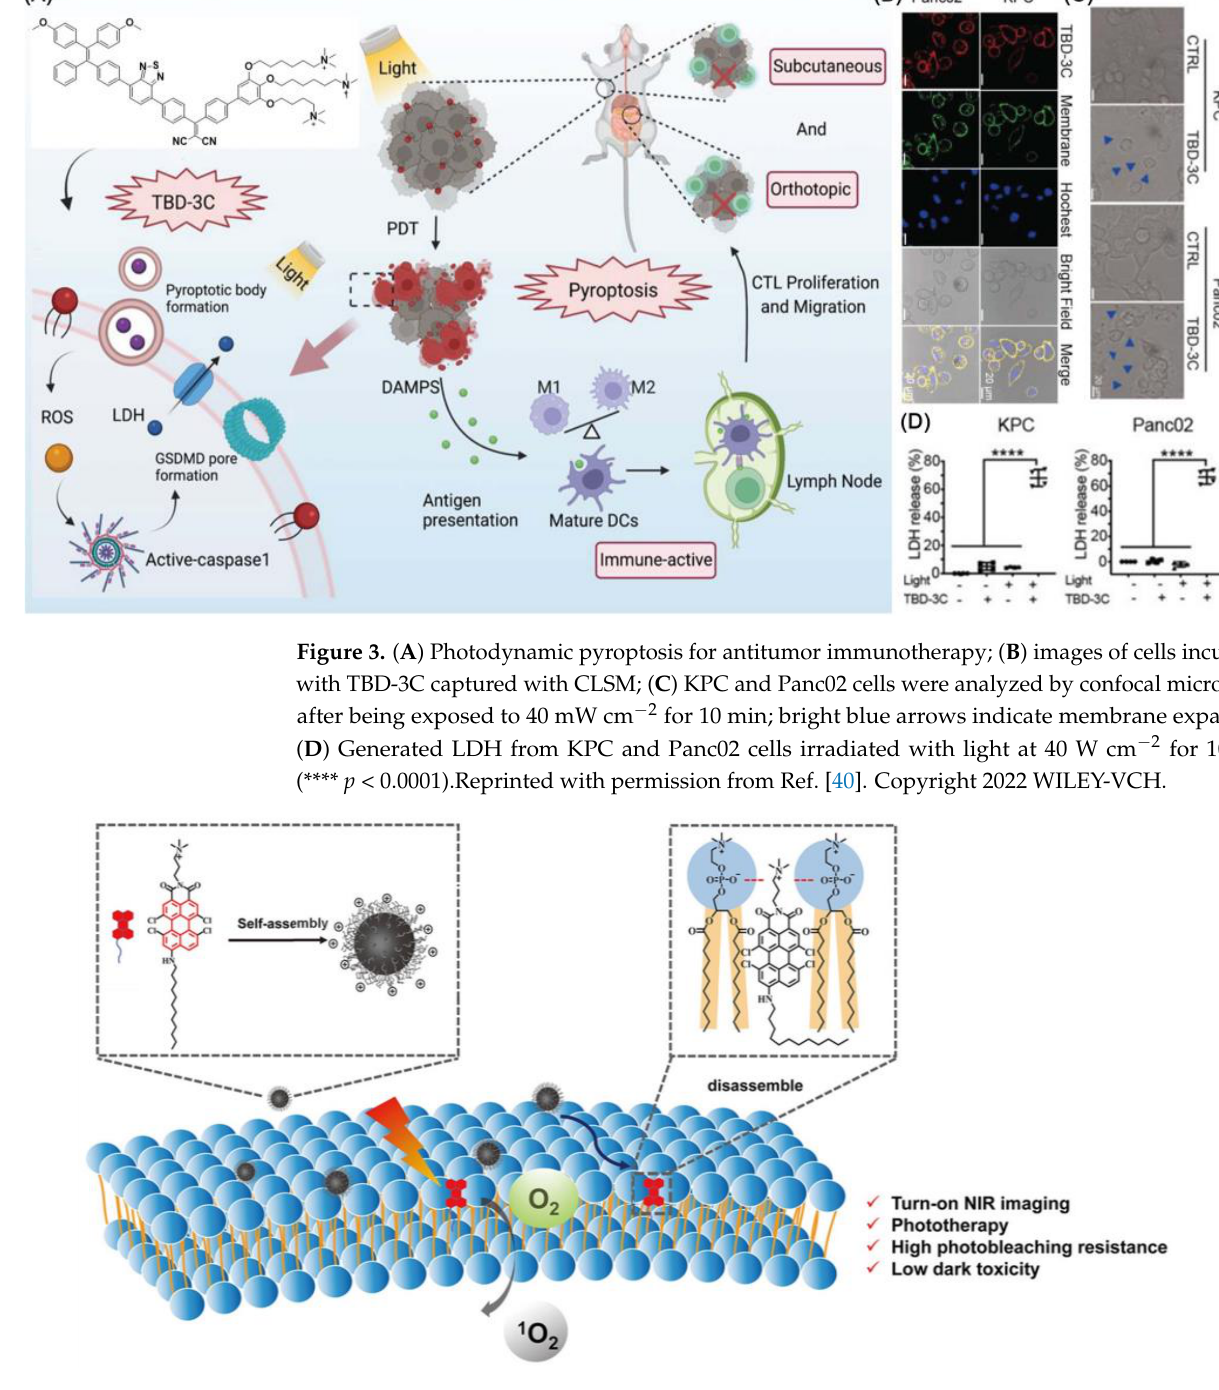
Figure 4. Schematic illustration of AP-based turn-on NIR fluorescence imaging and PDT. Reprinted with permission from Ref. [44]. Copyright 2021 American Chemical Society. 2.2. Lysosomal Targeting As the main digestive site in cells, lysosomes degrade intruding toxic substances us- ing more than 60 hydrolytic enzymes, making them crucial in autophagy and secretion [28,34,45]. Lysosome-targeted strategies have also become instructive and meaningful for PDT therapy. There are two main approaches: (1) Most examples target lysosomes